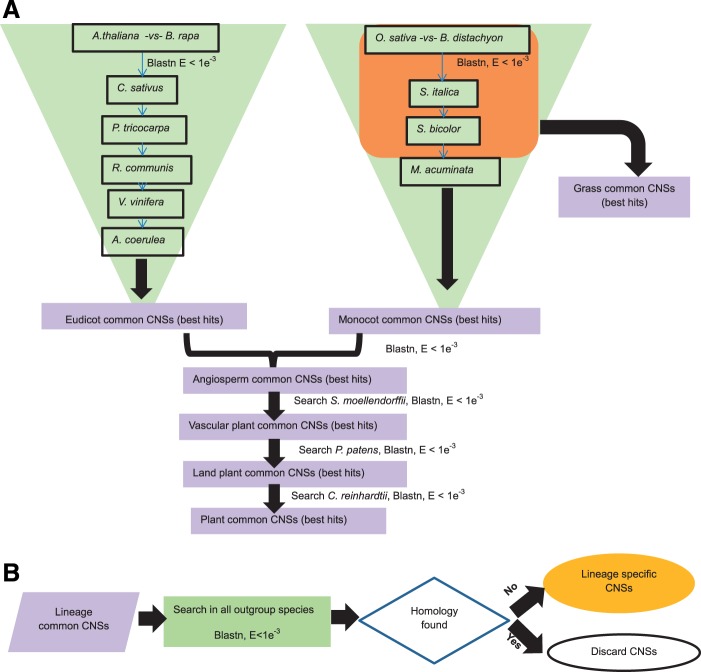
The flowcharts of the lineage-specific CNS determination. (A) Flowchart for lineage common CNS determination. (B) The flowchart for lineage-specific CNS determination.